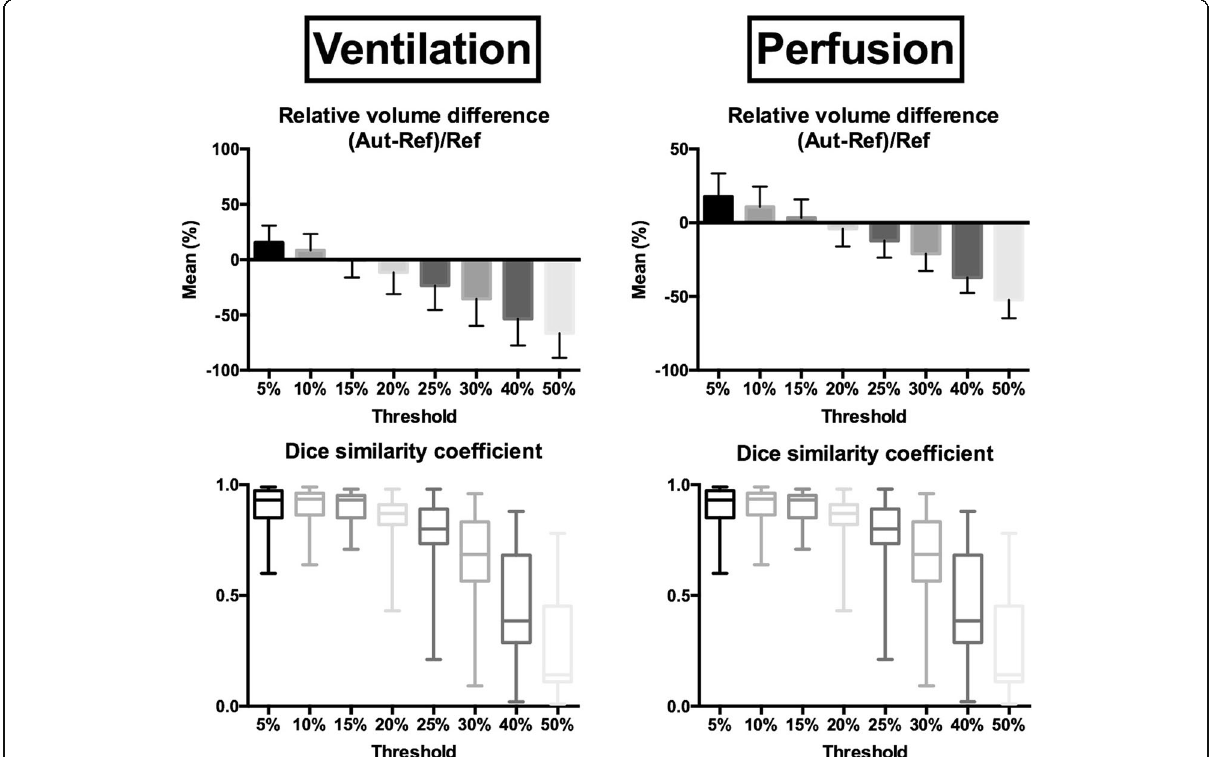
Fig. 2 Relative volume difference and Dice similarity coefficient between automatic contours and the reference standard. For volumes, mean and standard deviation (error bars) are displayed. For Dice similarity coefficient, median, interquartile ranges (boxes), and minimal and maximal values are